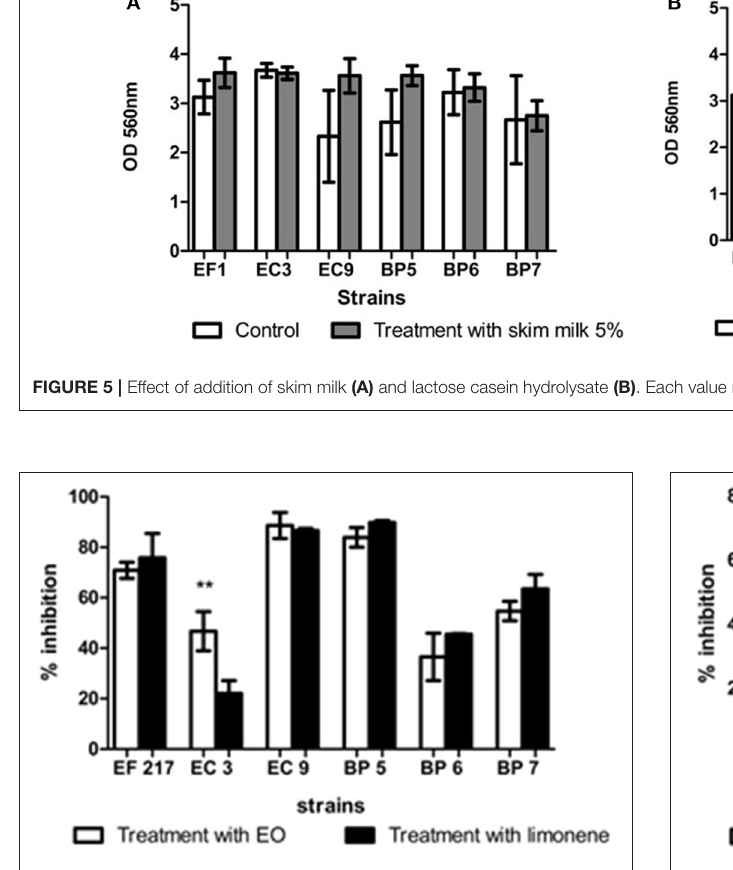
FIGURE 6 | Inhibitory effects of EO and limonene during biofilm formation. ** p < 0.01 compared with limonene. Each value represents means ± SD.